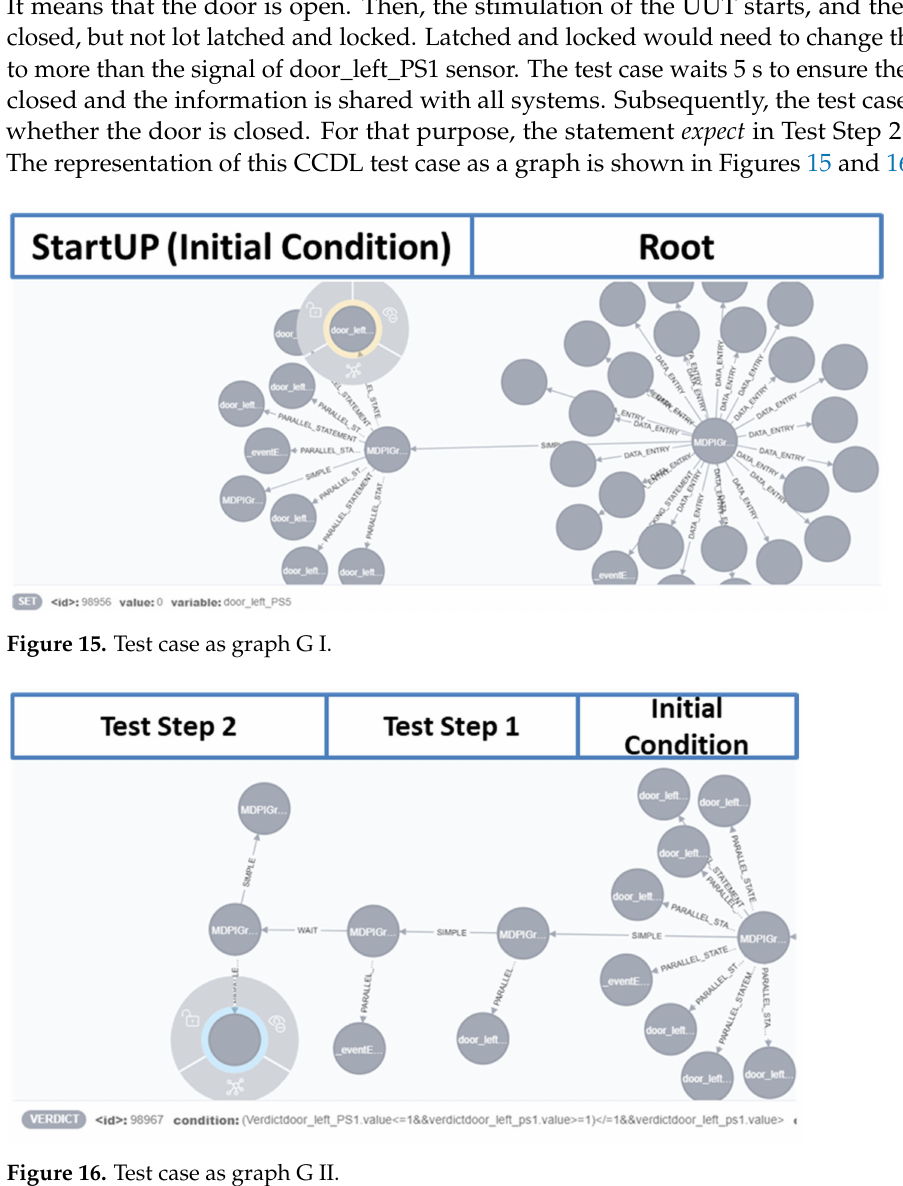
Figure 16. Test case as graph G